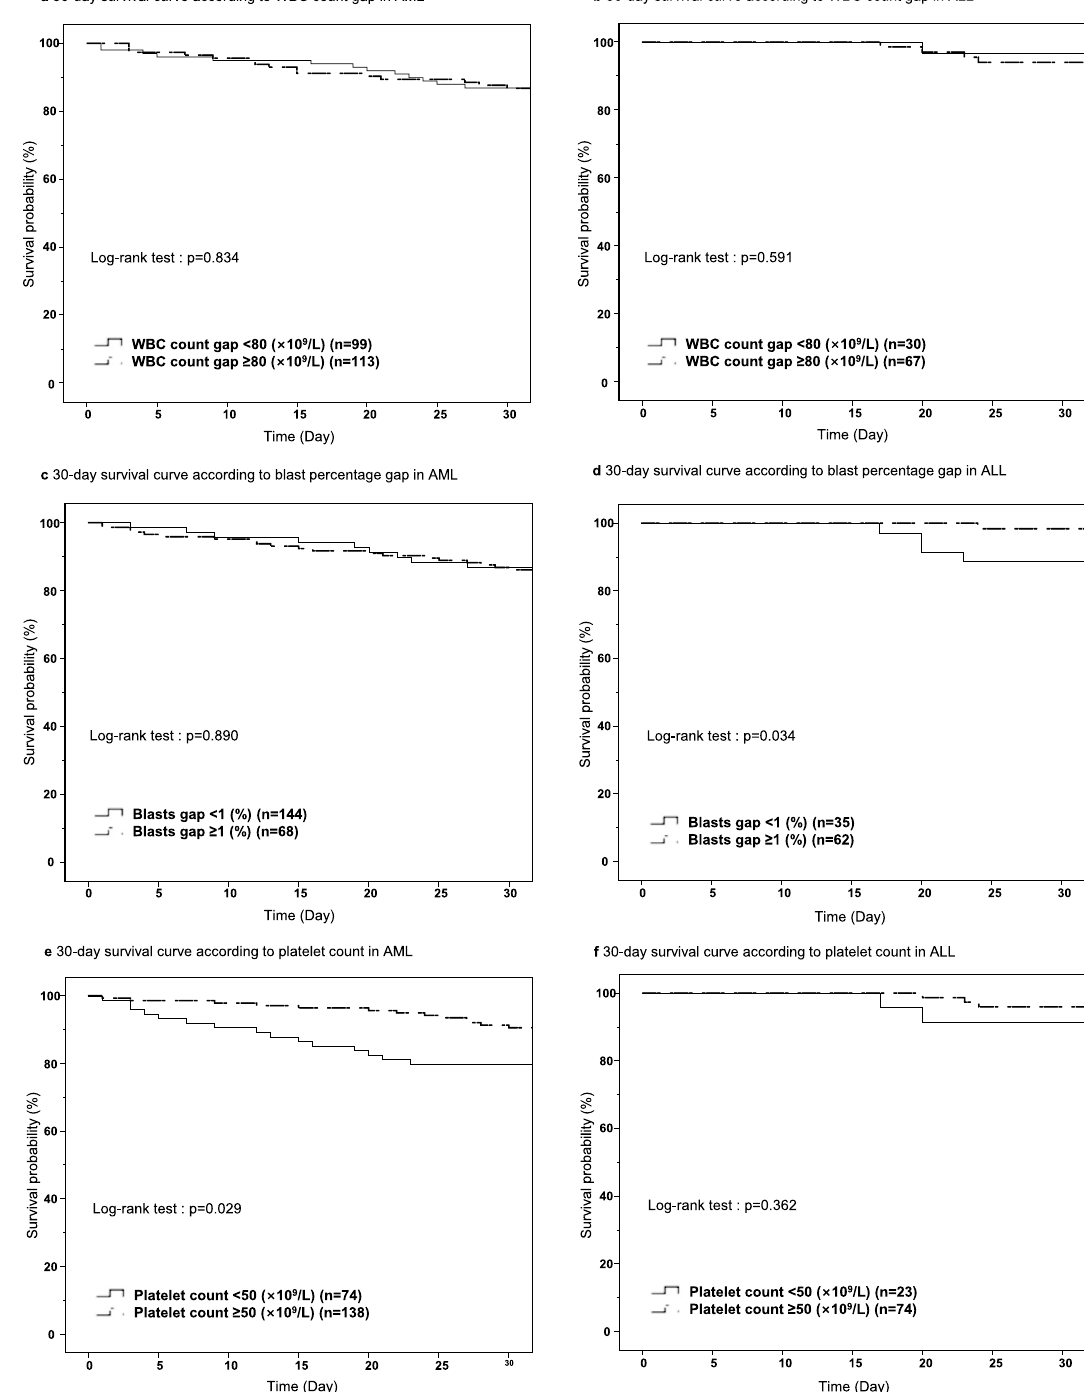
Figure 4. Survival among the subgroups according to CBC parameters in the acute myeloid leukaemia (AML) and acute lymphoblastic leukaemia (ALL) groups. CBC complete blood cell, WBC white blood